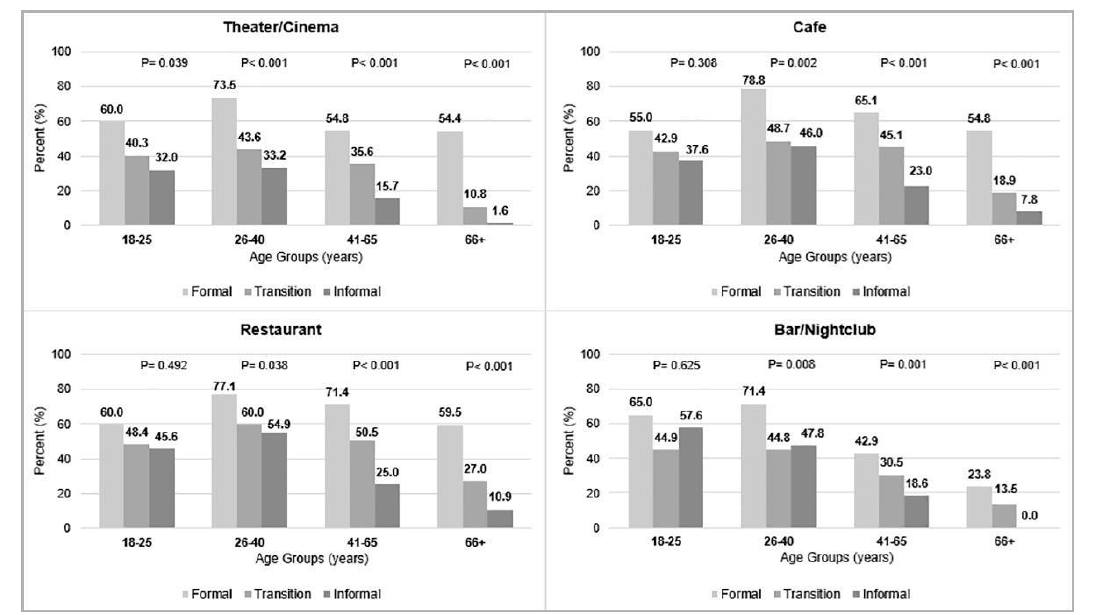
Figure 2. Frequency of the recreational activities by gender ( p, p -value ).